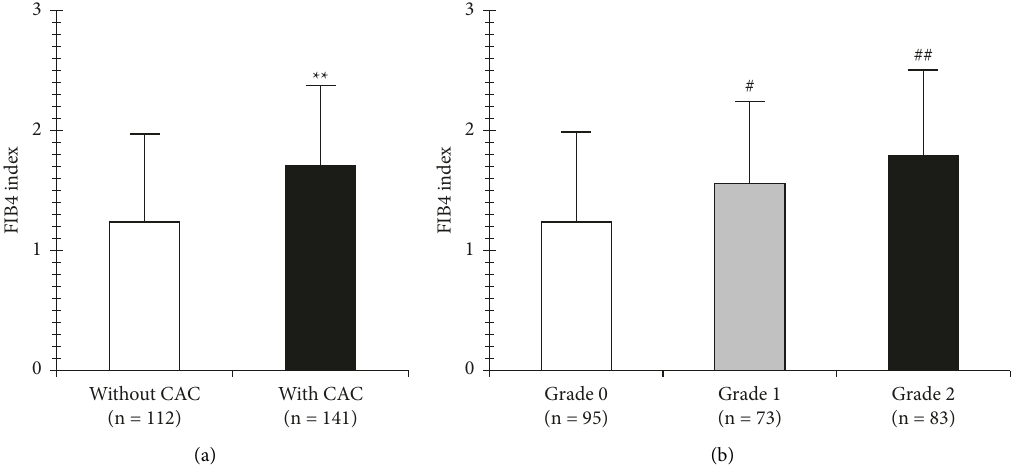
Figure 3: Distribution of FIB4 index in (a) CAC and (b) AAC grade. ∗∗ P < 0 . 001 vs. without; # P � 0 . 001 and ## P < 0 . 001 vs. AAC grade 0. FIB4 index, fibrosis-4 index; CAC, carotid artery calcification; AAC, aortic arch